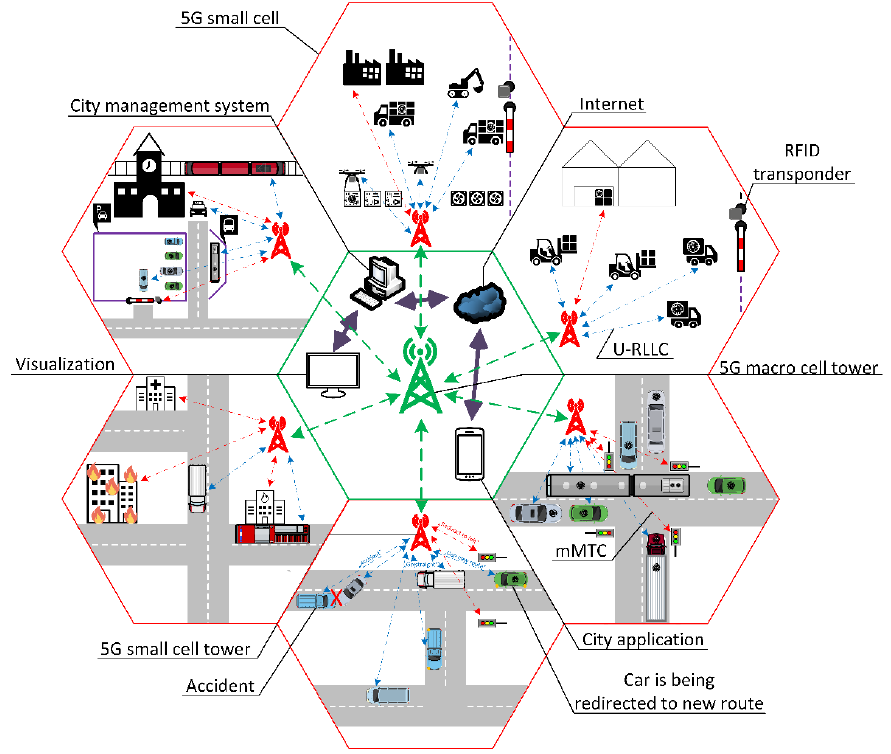
Figure 2. Smart City infrastructure elements with a 5G network, RFID transponders, and a manage- ment center.